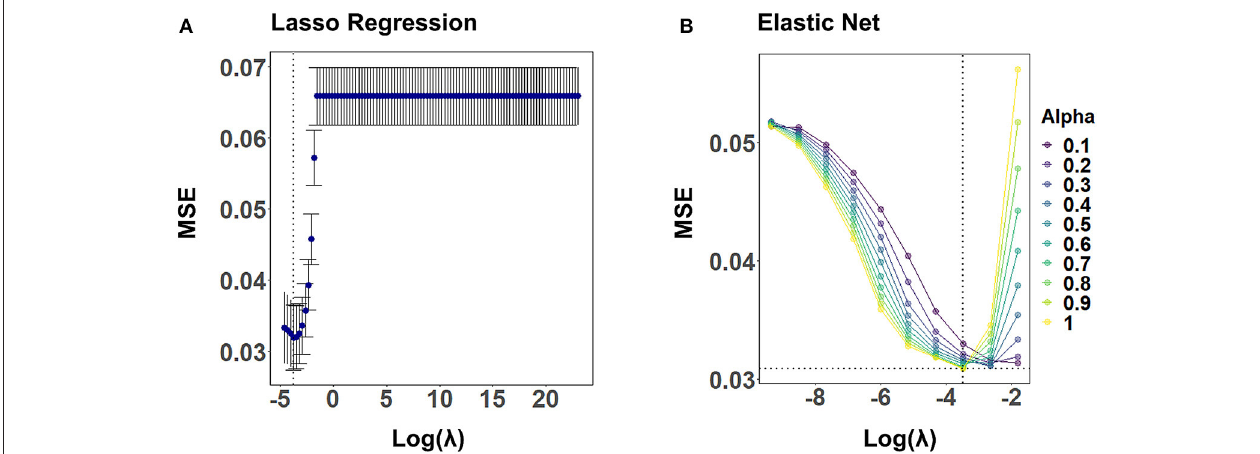
FIGURE 4 | Hyperparameter selection for lasso regression and elastic net using 10-fold CV, exemplarily for C A2 and a randomly selected imputed data set. Both plots display the mean-squared error (MSE) as a function of log( λ ). The dotted line indicates the values leading to the smallest MSE. (A) Tuning of λ for lasso regression. The standard error of λ across CV-folds is shown. (B) Tuning of λ for different levels of α with elastic